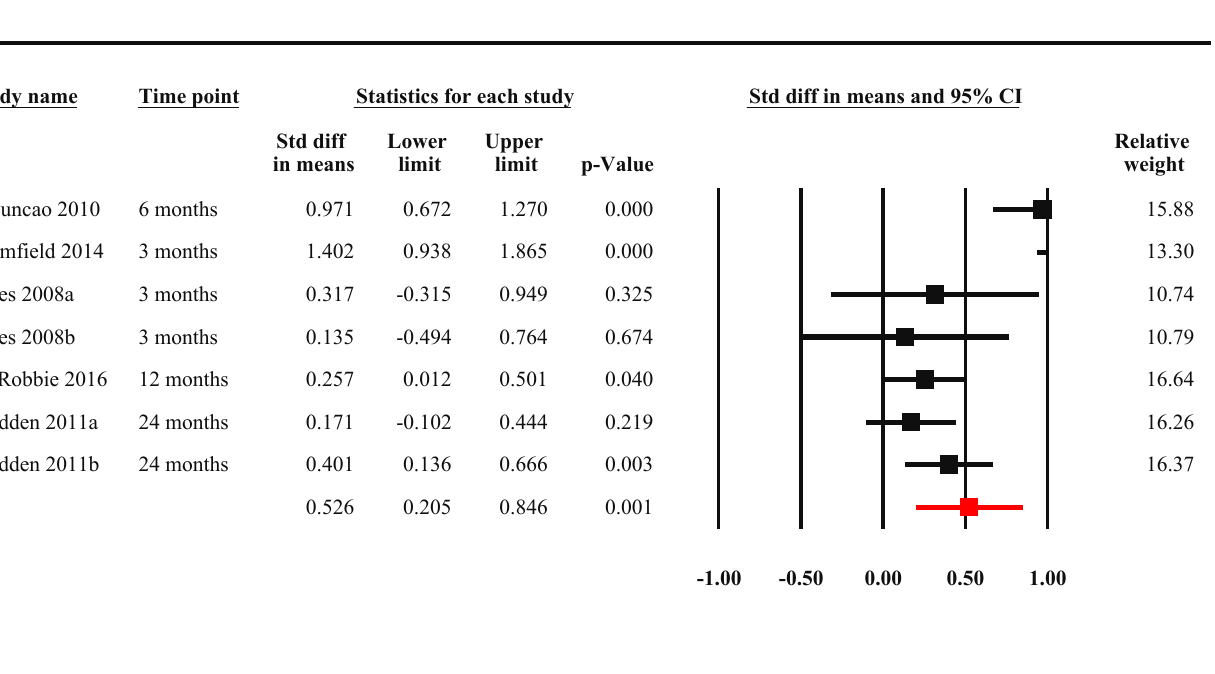
Figure 5. Publication bias in reporting of serum HbA1c levels outcome.